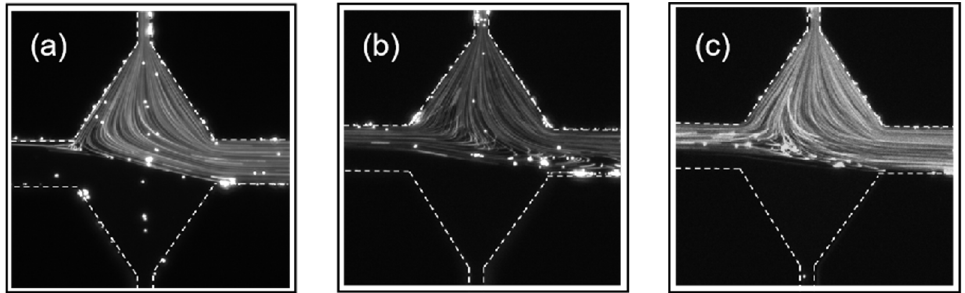
Figure 6. PAM flow pattern in the RCM at ( a ) Q = 50 μ L/hour, ( b ) Q = 200 μ L/hour, and ( c ) Q = 1000 μ L/hour.